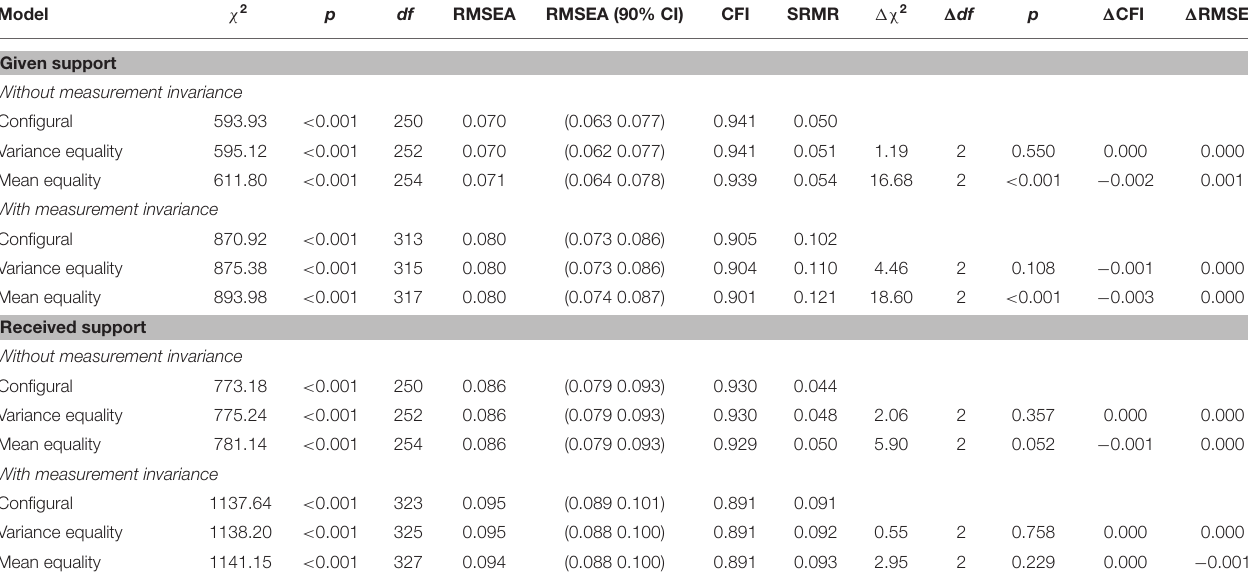
TABLE 6 | Cross-national LCM for similarity models within the mother–child relationship.